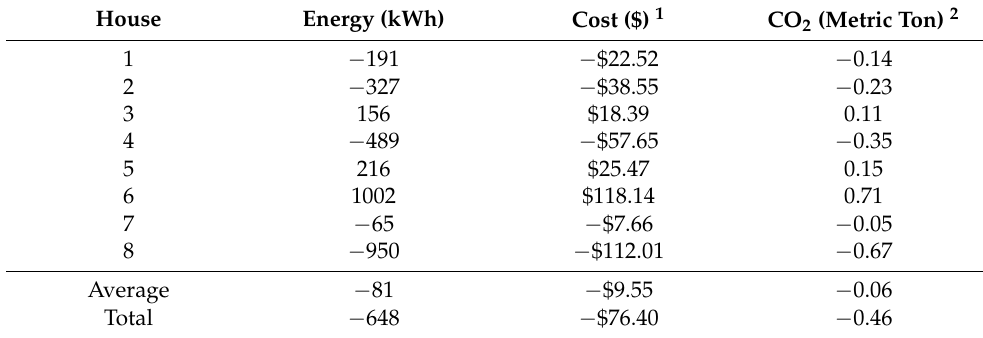
Table 3. Household savings (total for 3–month